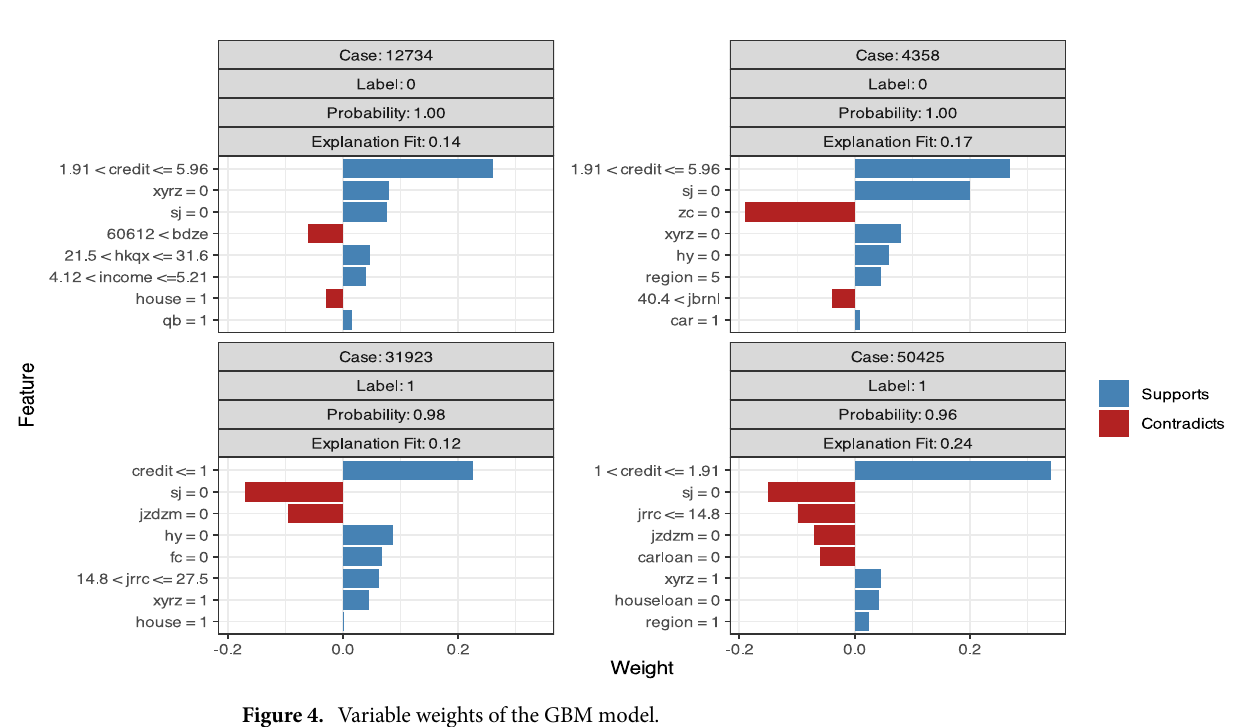
Figure 4. Variable weights of the GBM